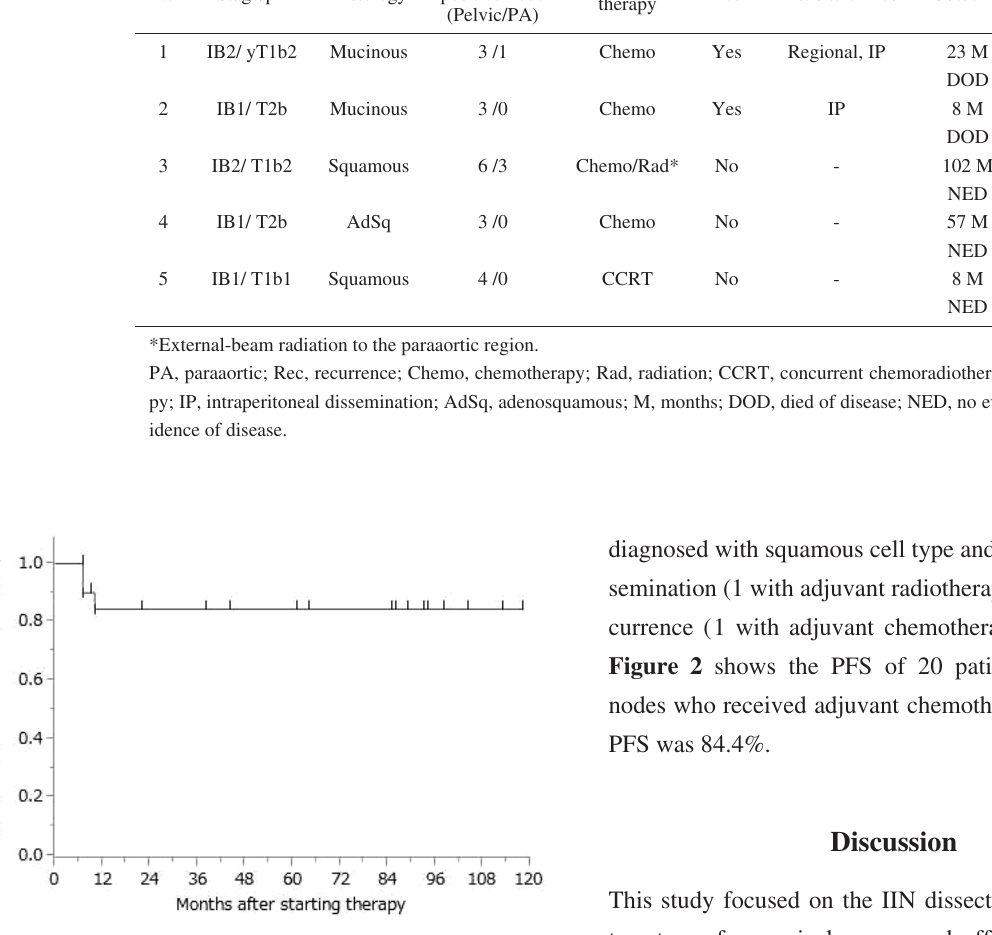
Fi g . 2 The pro g ression-free s u r v i v al of node-positi v e patients w ith adj uv ant chemotherap y . The median follo w - u p, 86 (ran g e 10- 118)